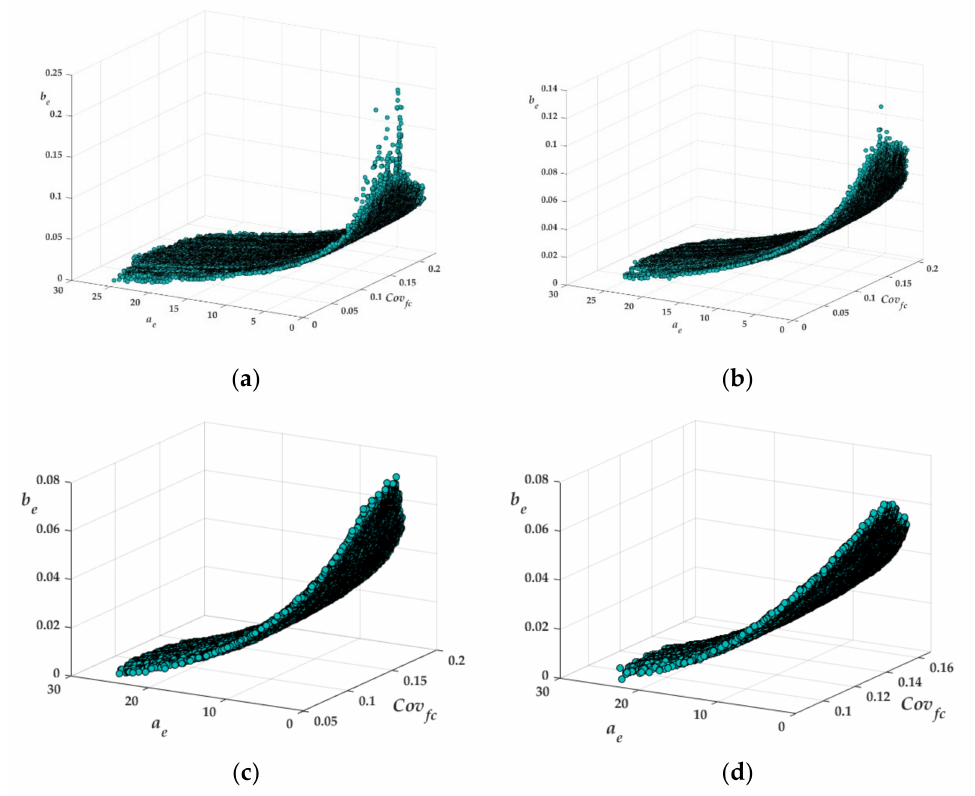
Figure 5. Relationship between the coefficients of the calibrated exponential empirical laws ( a e , b e ) and the coefficient of variation of the concrete strength Cov fc : ( a ) m = 8; ( b ) m = 11; ( c ) m = 15, ( d ) m =